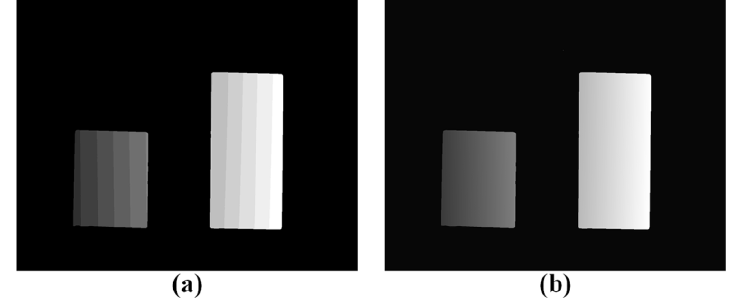
Figure 15. ( a ) Fringe order map; ( b ) absolute phase map.